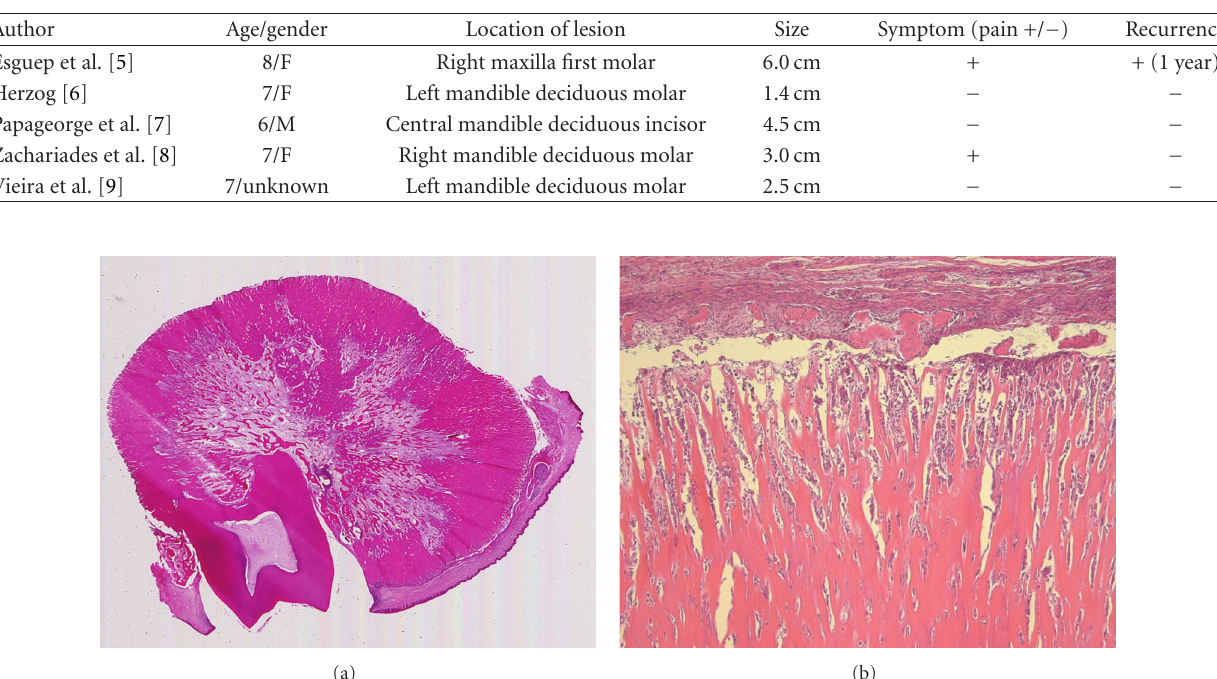
Figure 4: (a) The tooth root was embedded in the tumour mass. (b) The periphery of the cementoblastoma showed numerous cementoblasts forming cementum-like mineralized tissue with basophilic reversal lines